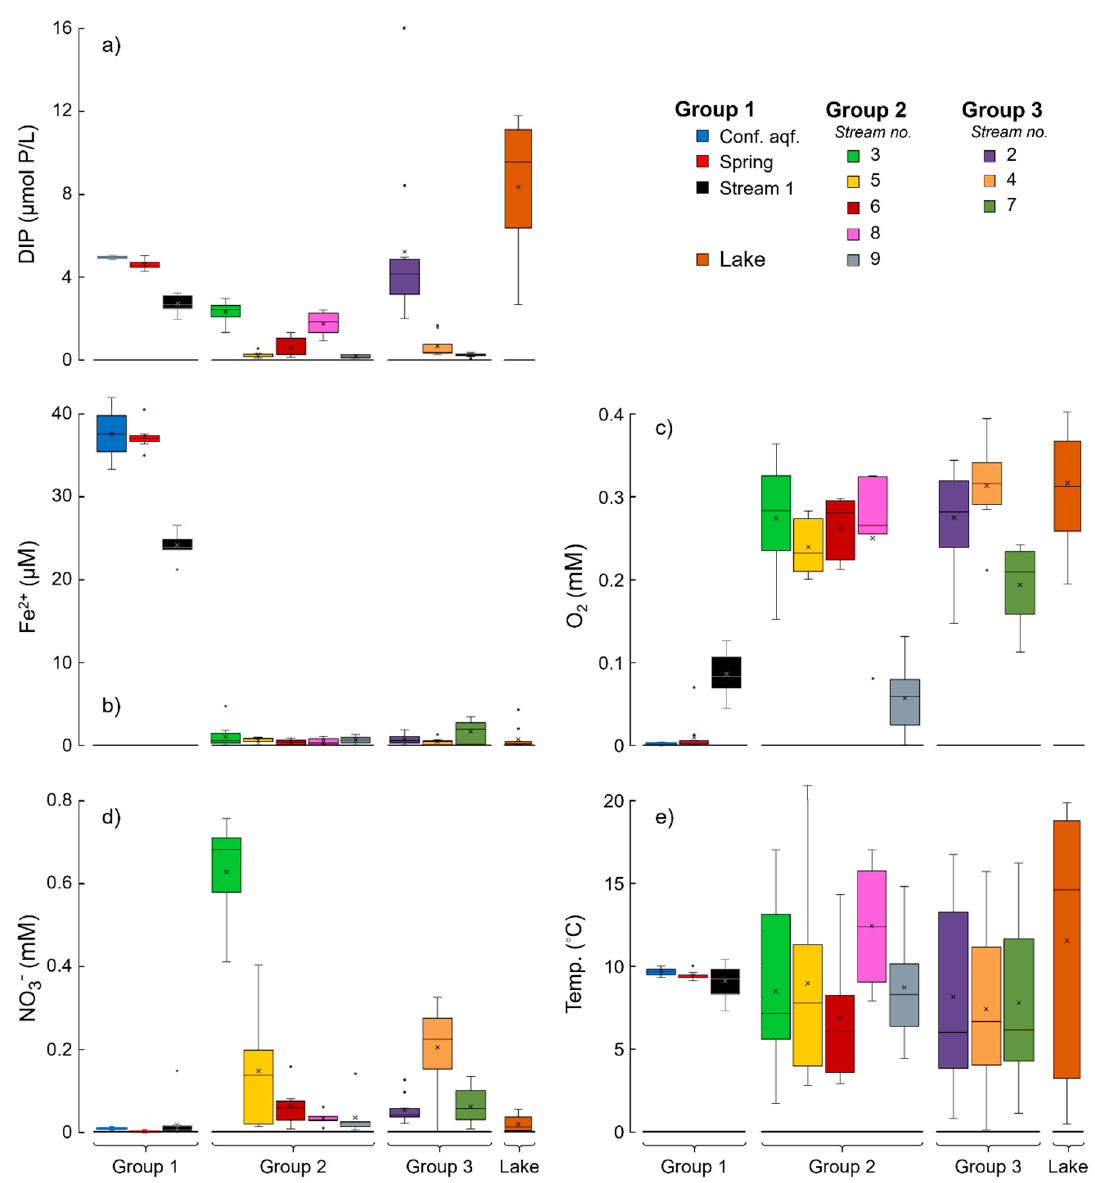
Figure 5. Boxplot showing concentrations of dissolved inorganic orthophosphate (DIP) ( a ), Fe 2+ ( b ), O 2 ( c ), and NO 3 − ( d ) and temperature ( e ) in the streams, the spring, Lake Nørresø, and in the regional confined aquifer. Note that along the x -axis the data for the different streams, the spring, and confined aquifer are grouped with respect to their isotopic grouping (cf. Figure 3). Lower and upper whisker indicates the minimum and maximum values, respectively, excluding statistical outliers. Median and mean value is depicted in each box by a straight horizontal line and a cross, respectively.